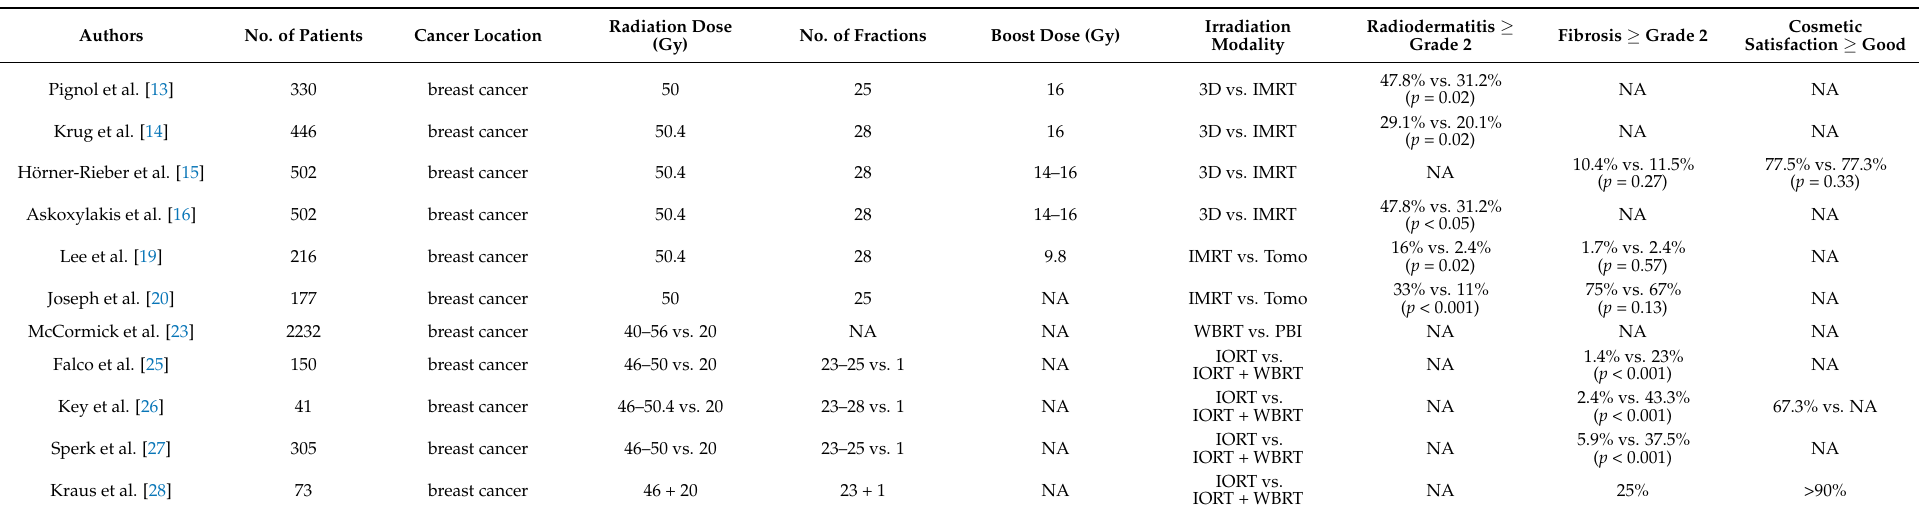
Table 1. Acute and late toxicities depending on the irradiation